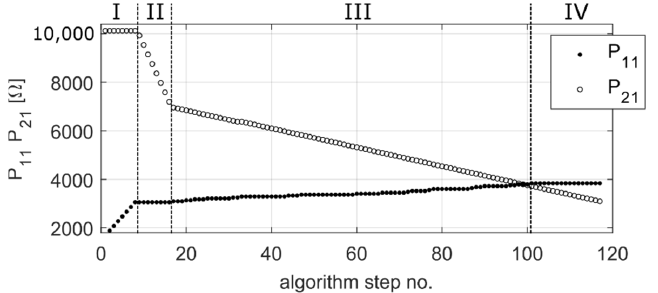
Figure 8. Successive stages of automatic adjustment of dynamic properties of the hot-wire anemom- eter.